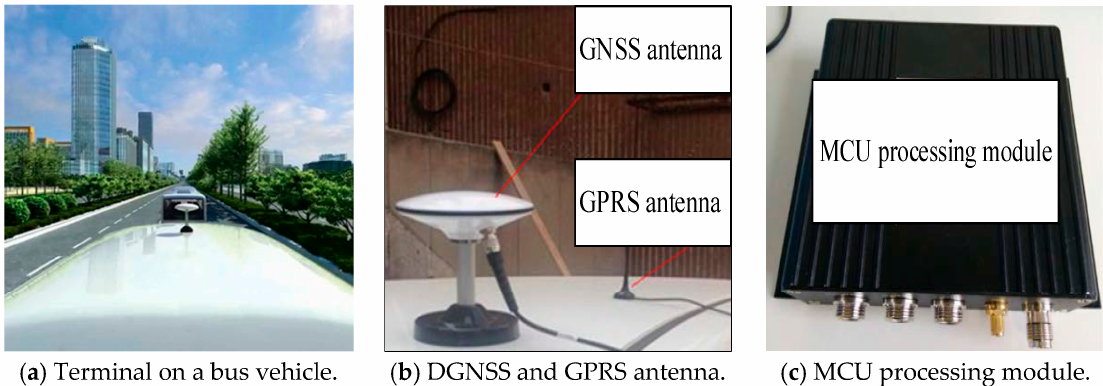
Figure 5. Hardware of the DGNSS terminal on a bus vehicle.